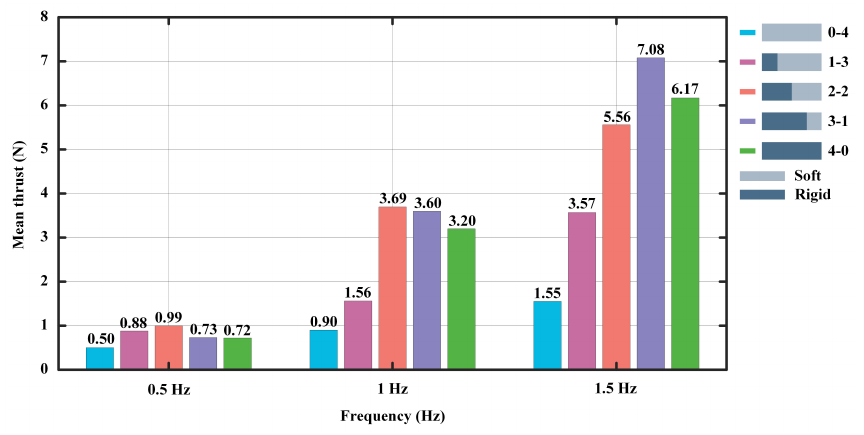
Figure 9. The mean thrust of each